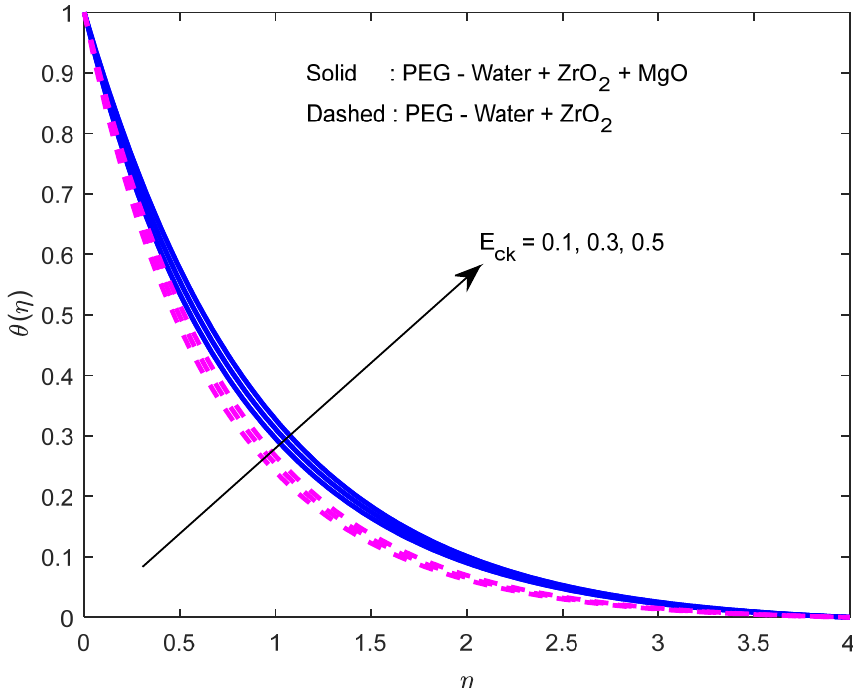
Figure 11. Effects on velocity due to φ 1 .